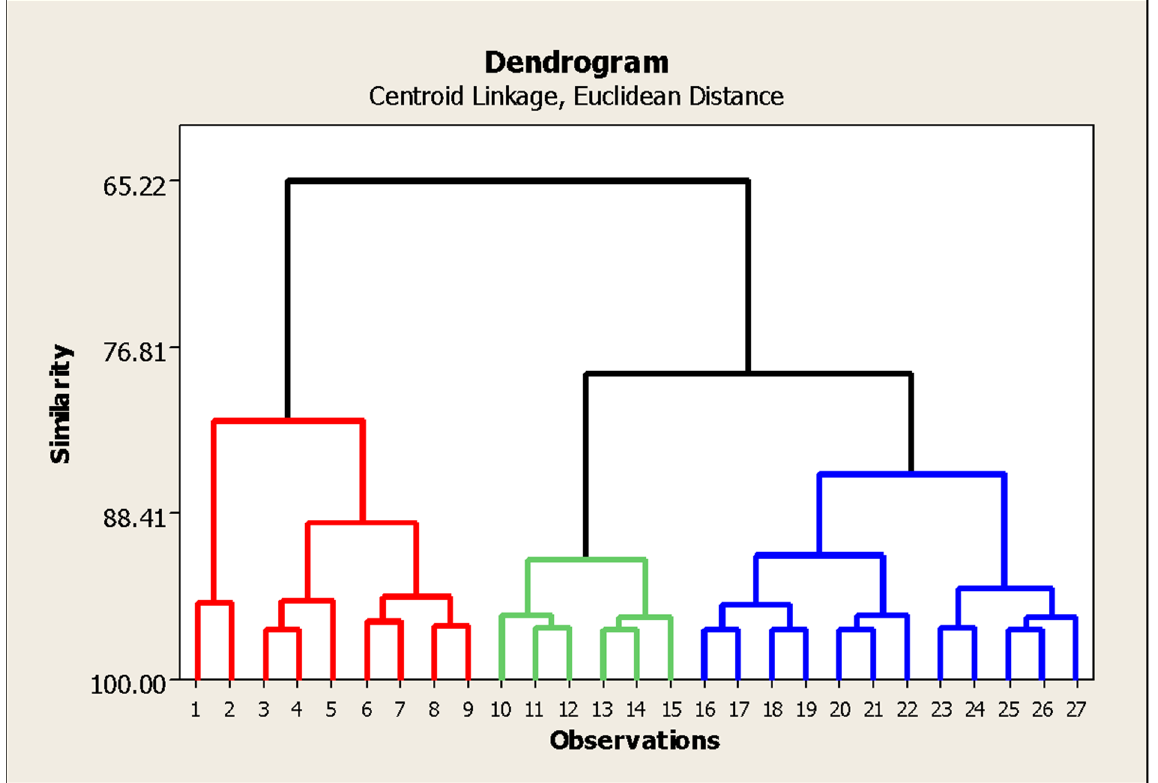
Figure 3. Dendrogram depicting the ranking and categorization of 27 specific threats to biodiversity in Papua New Guinea based on quantitative SWOT and multivariate cluster analyses. Red (1–9) denotes “High” threats, Green (10–15) denotes “Medium” threats, and Blue (16–27) denotes “Low” threats.